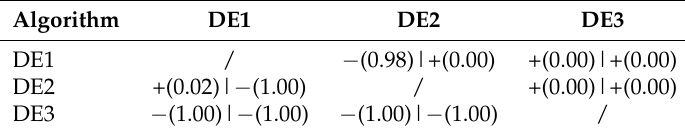
Table 4. eDSC analysis at D*100,000 FEs.